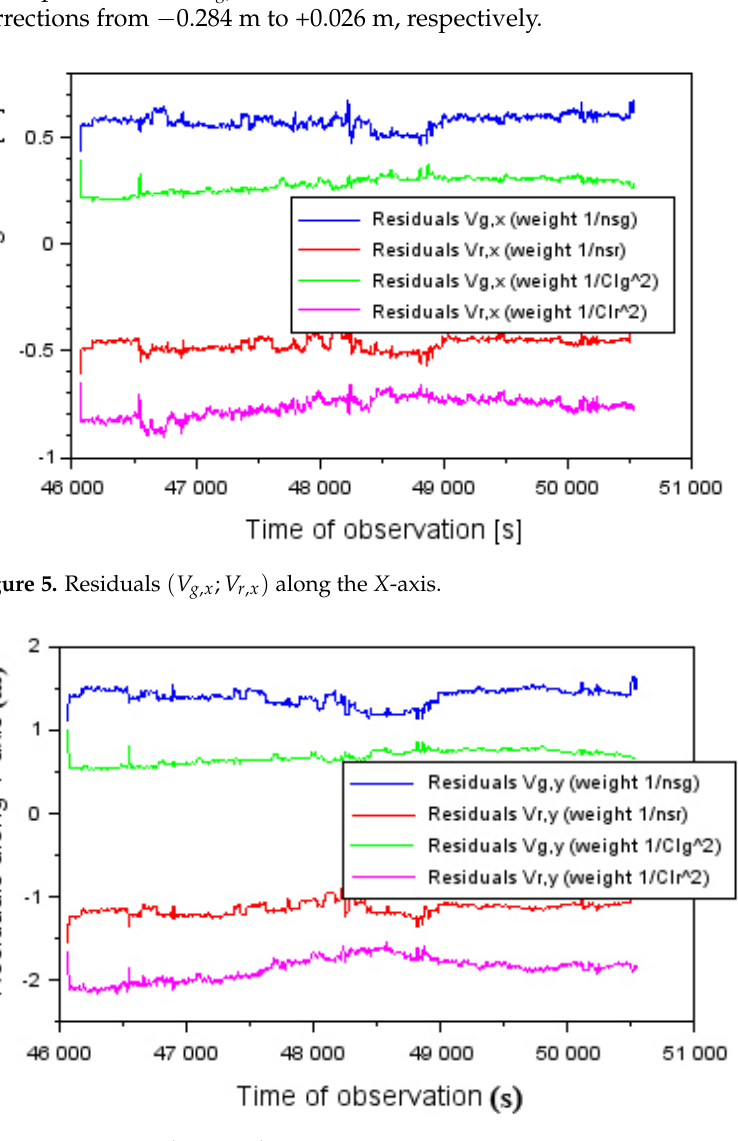
Figure 6. Figure 6. Residuals along the Y-axis.